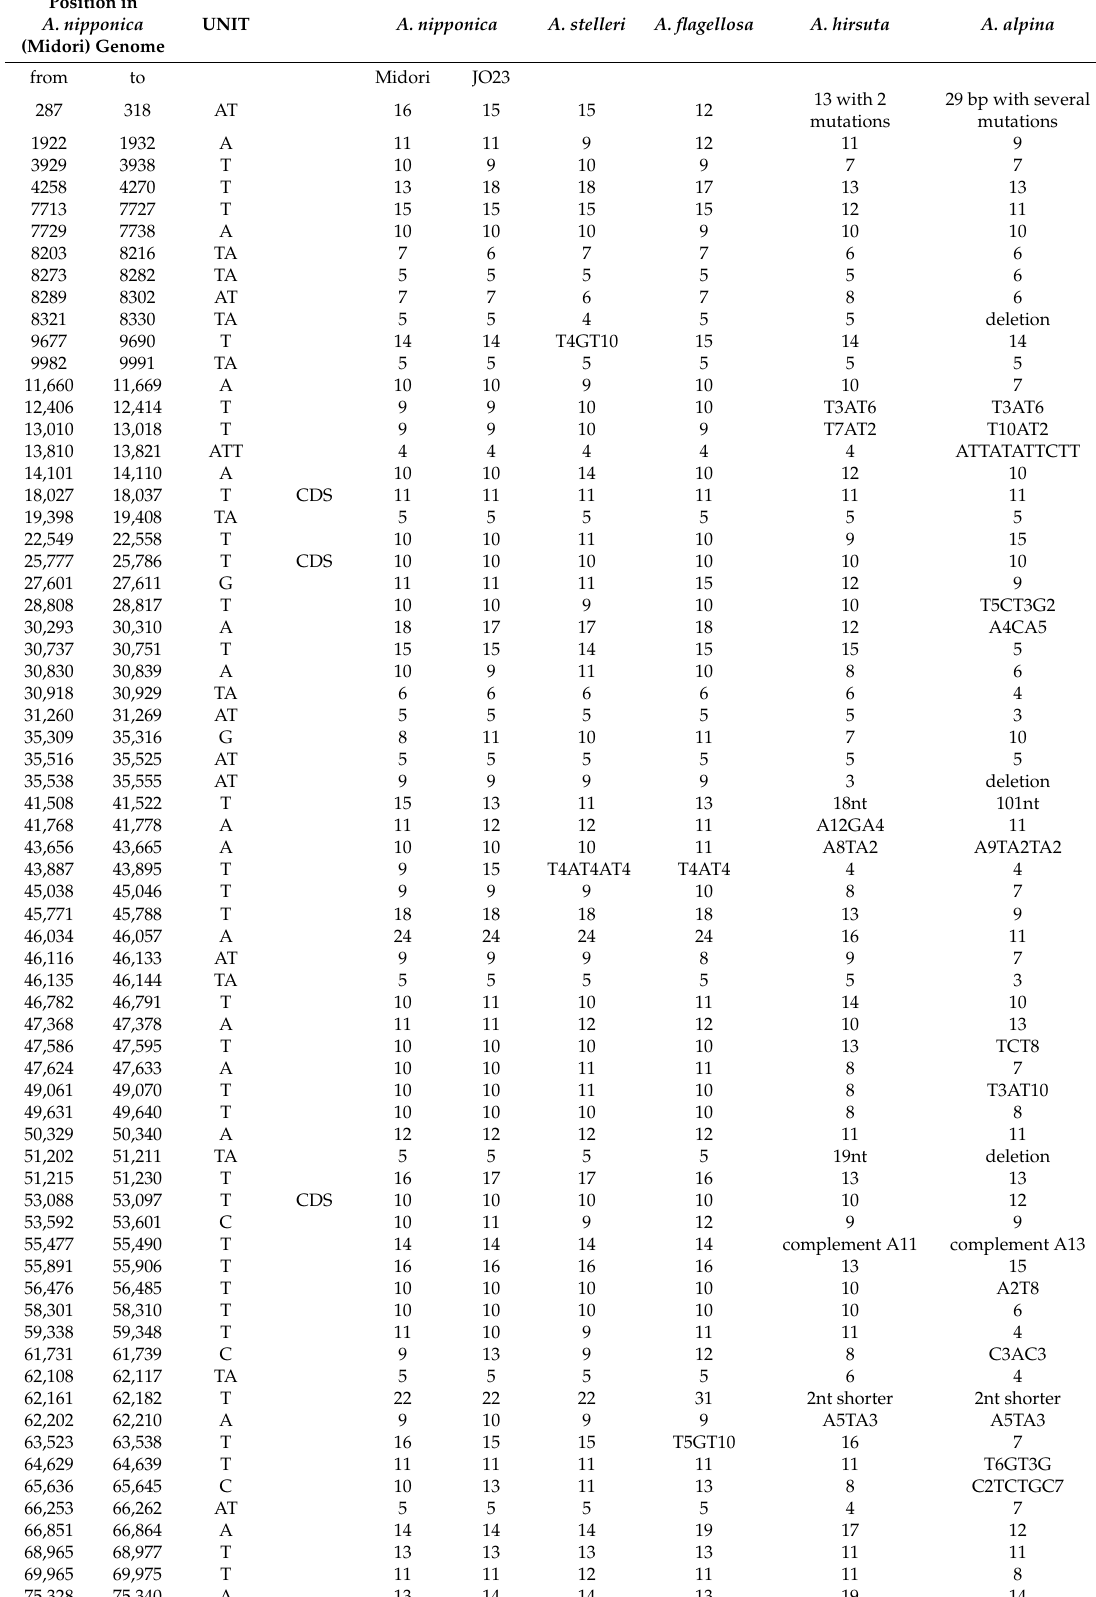
Table 3. Simple sequence repeats (SSRs) in Arabis chloroplast